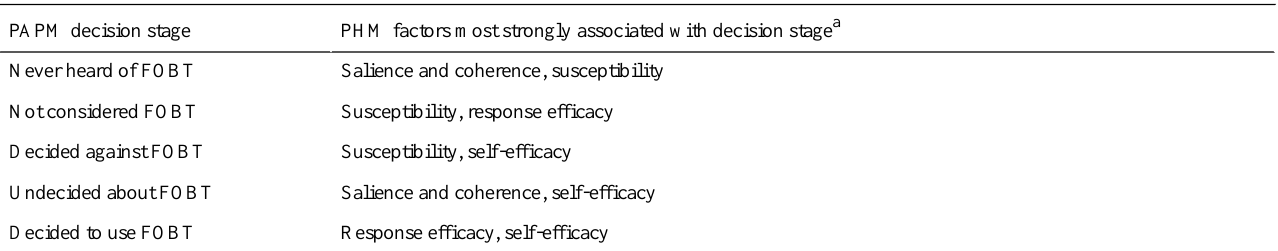
Table 4. Relating Preventive Health Model (PHM) factors to Precaution Adoption Process Model (PAPM) decision stage for colorectal cancer screening via fecal occult blood test